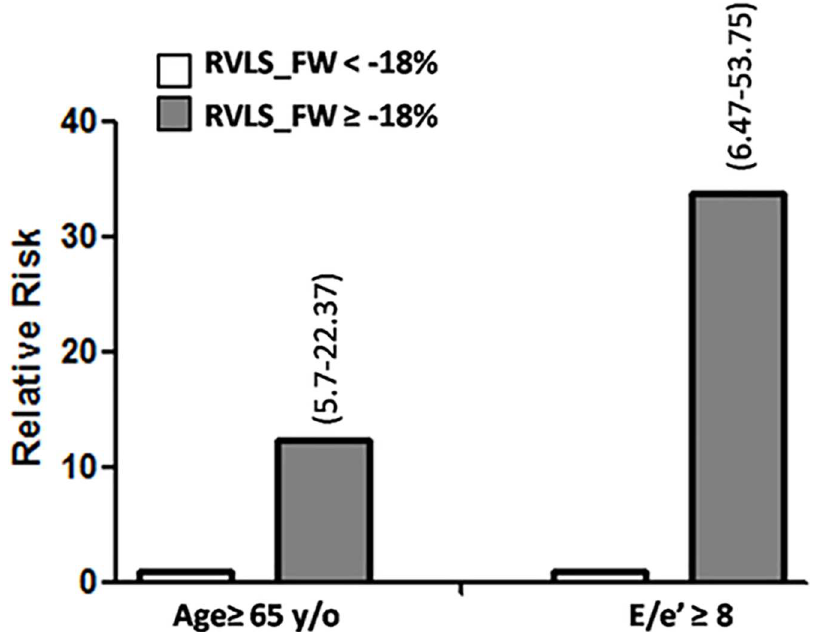
Fig 3. Relative risks of impaired functional capacity in subjects with old age ( ≧ 65 y/o) and upper limit of estimated wedge pressure(E/e’ ≧ 8) who have relatively preserved( < -18%) or declined RVLS_FW ( ≧ -18%). Abbreviations as describedin Tables 1 and